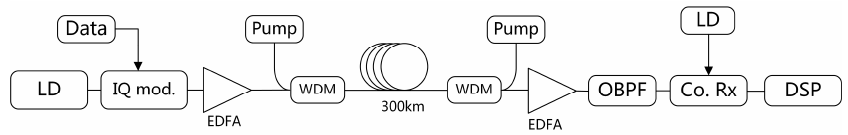
Figure 3. Simulation setup: LD: laser diode; IQ mod.: IQ modulator; OBPF: optical band-pass filter; Co. Rx: coherent receiver.